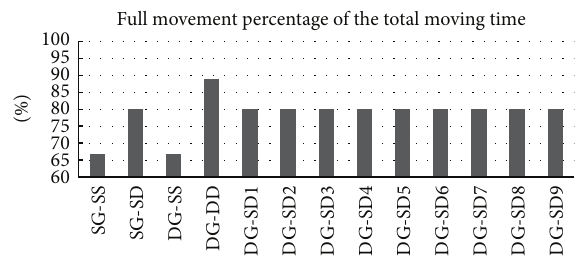
Figure 12: Full movement percentage of double